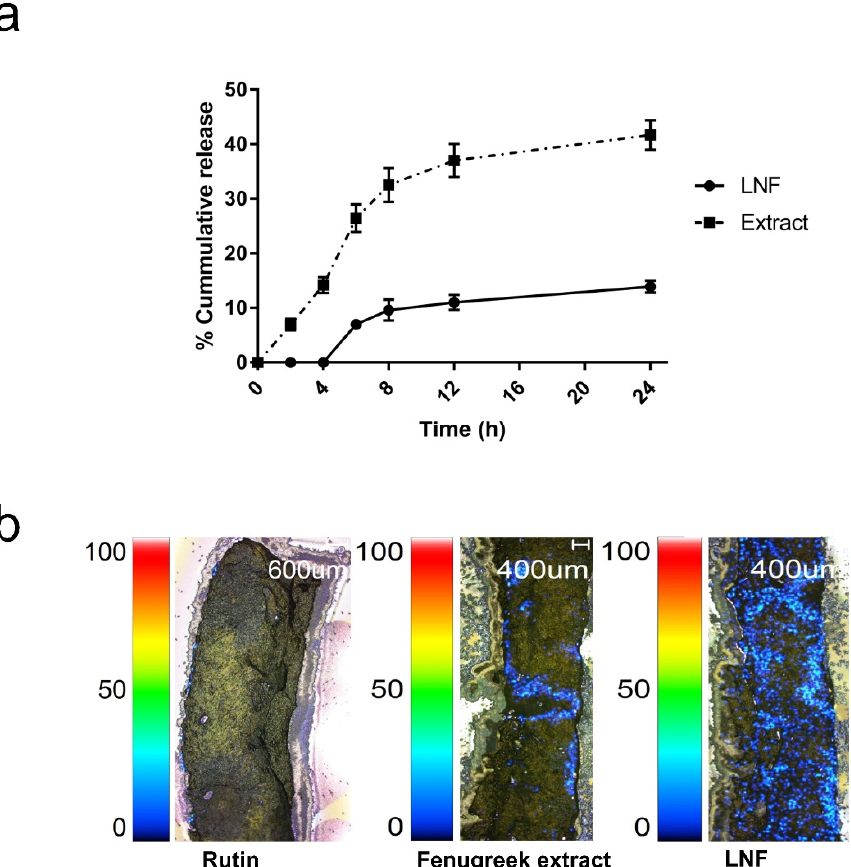
Figure 5. The releasing profile and skin penetration of formulated LNF: ( a ) In vitro releasing profiles of LNF within 24 h using Franz diffusion cells. ( b ) Porcine skin permeabilization. The IMS image showed the cumulative amount of rutin (blue) permeated through porcine skin, which was treated with rutin standard, fenugreek extract, and LNF for 24 h. Rutin was detected at 609 m/z.